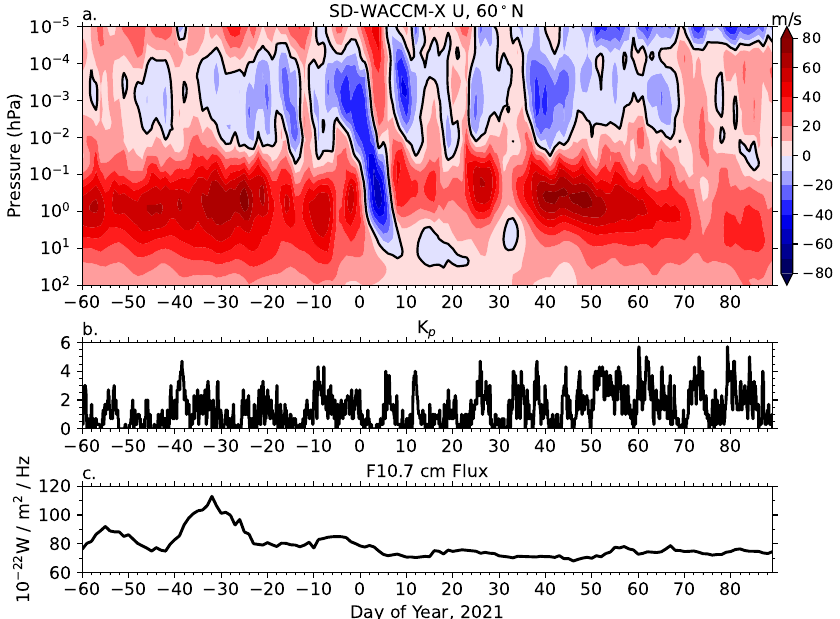
Figure 1. Variability in the ( a ) zonal mean zonal winds at 60 ◦ N from SD-WACCM-X, ( b ) geomagnetic K p index, and ( c ) F10.7 cm solar flux during the 2020–2021